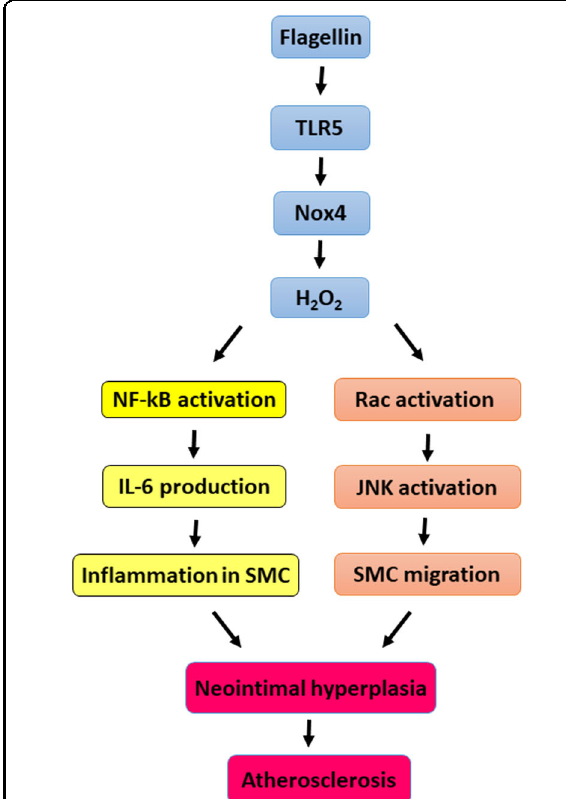
Fig. 7 Proposed function of the TLR5-Nox4 cascade in the migration of smooth muscle cells. In SMCs, the fl agellin-TLR5-Nox4 axis stimulates H 2 O 2 generation. Nox-mediated H 2 O 2 production induces NF-kB activation, leading to IL-6 production for in fl ammation of SMCs and activating the Rac-JNK cascade for SMC migration. We have demonstrated that the fl agellin-TLR5-Nox4 cascade is